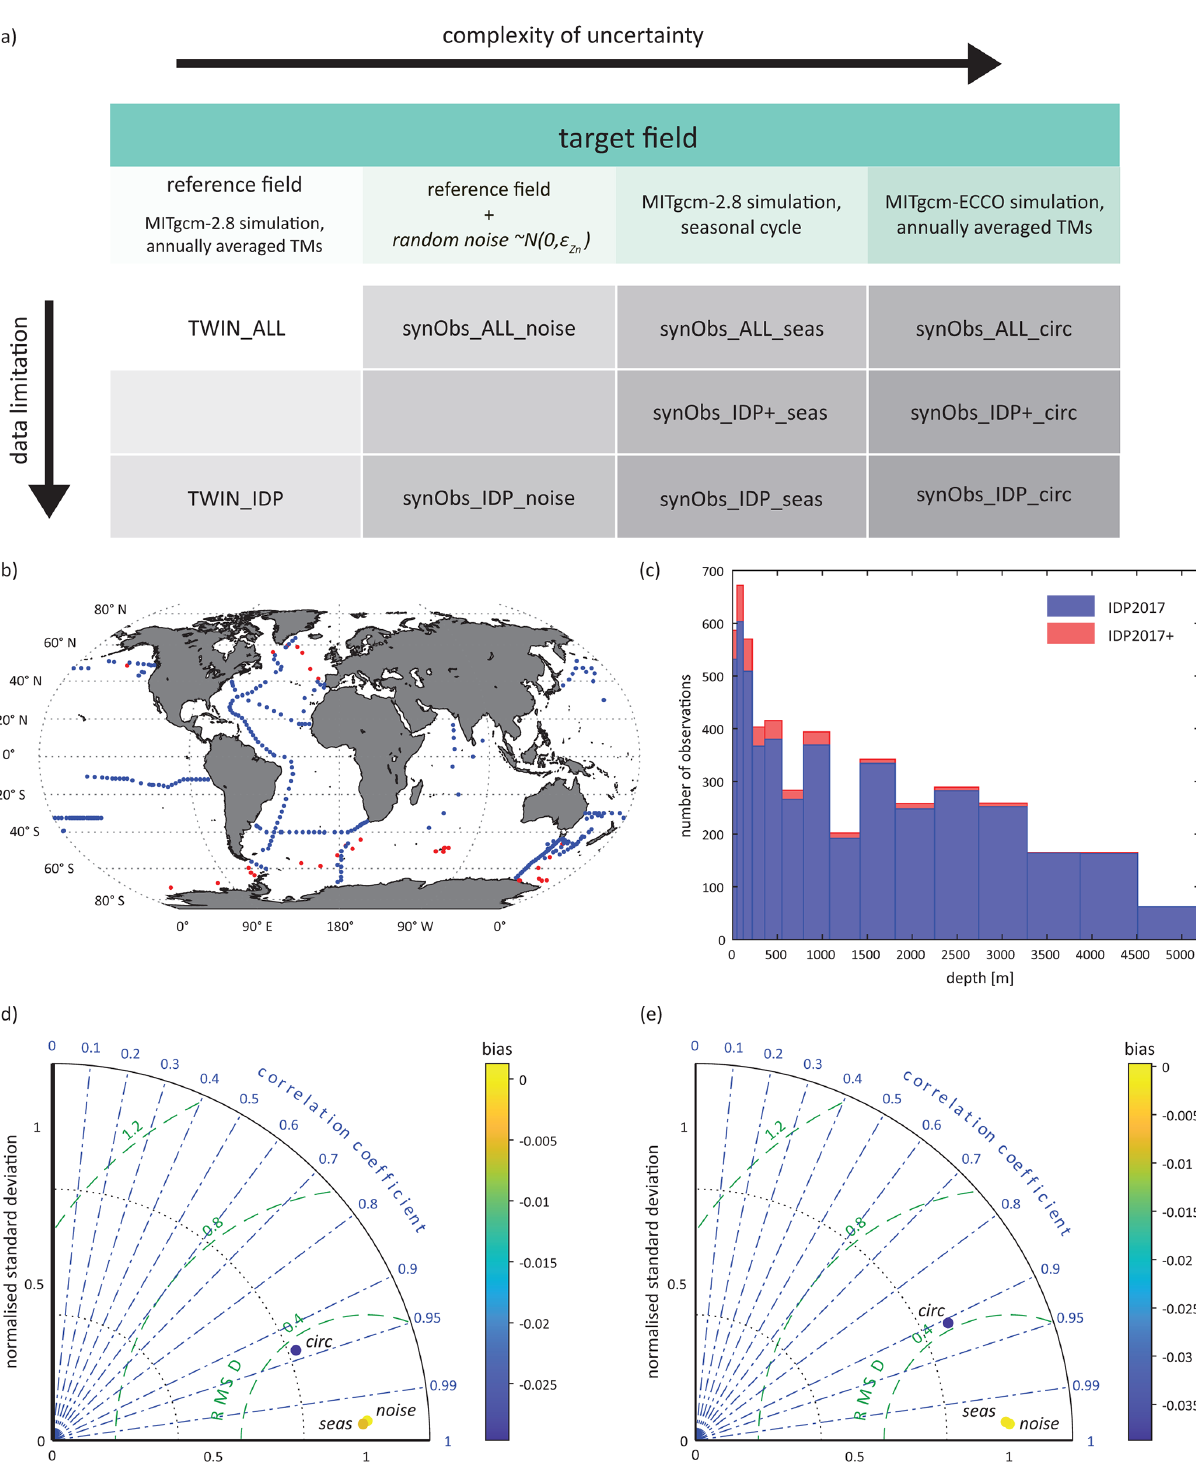
Figure 1. (a) Overview of the experiments carried out in this study. For experiments in the first row (ALL), optimisation was carried out using full data coverage. For experiments in the second and third row, modelled and target fields were interpolated to the three-dimensional geographical coordinates of locations which have Zn data available in an extended version of the GEOTRACES IDP2017 (IDP + ; red dots in panel b ) and in the original version of this data product (IDP, blue dots in panel b ). (c) Distribution of IDP2017( + ) observations in model depth layers of MITgcm-2.8. (d) Taylor diagram comparing target fields of the simulations listed in panel (a) to the reference field; (e) same as (d) but with data coverage limited to IDP2017 coordinates. RMSD: root mean square